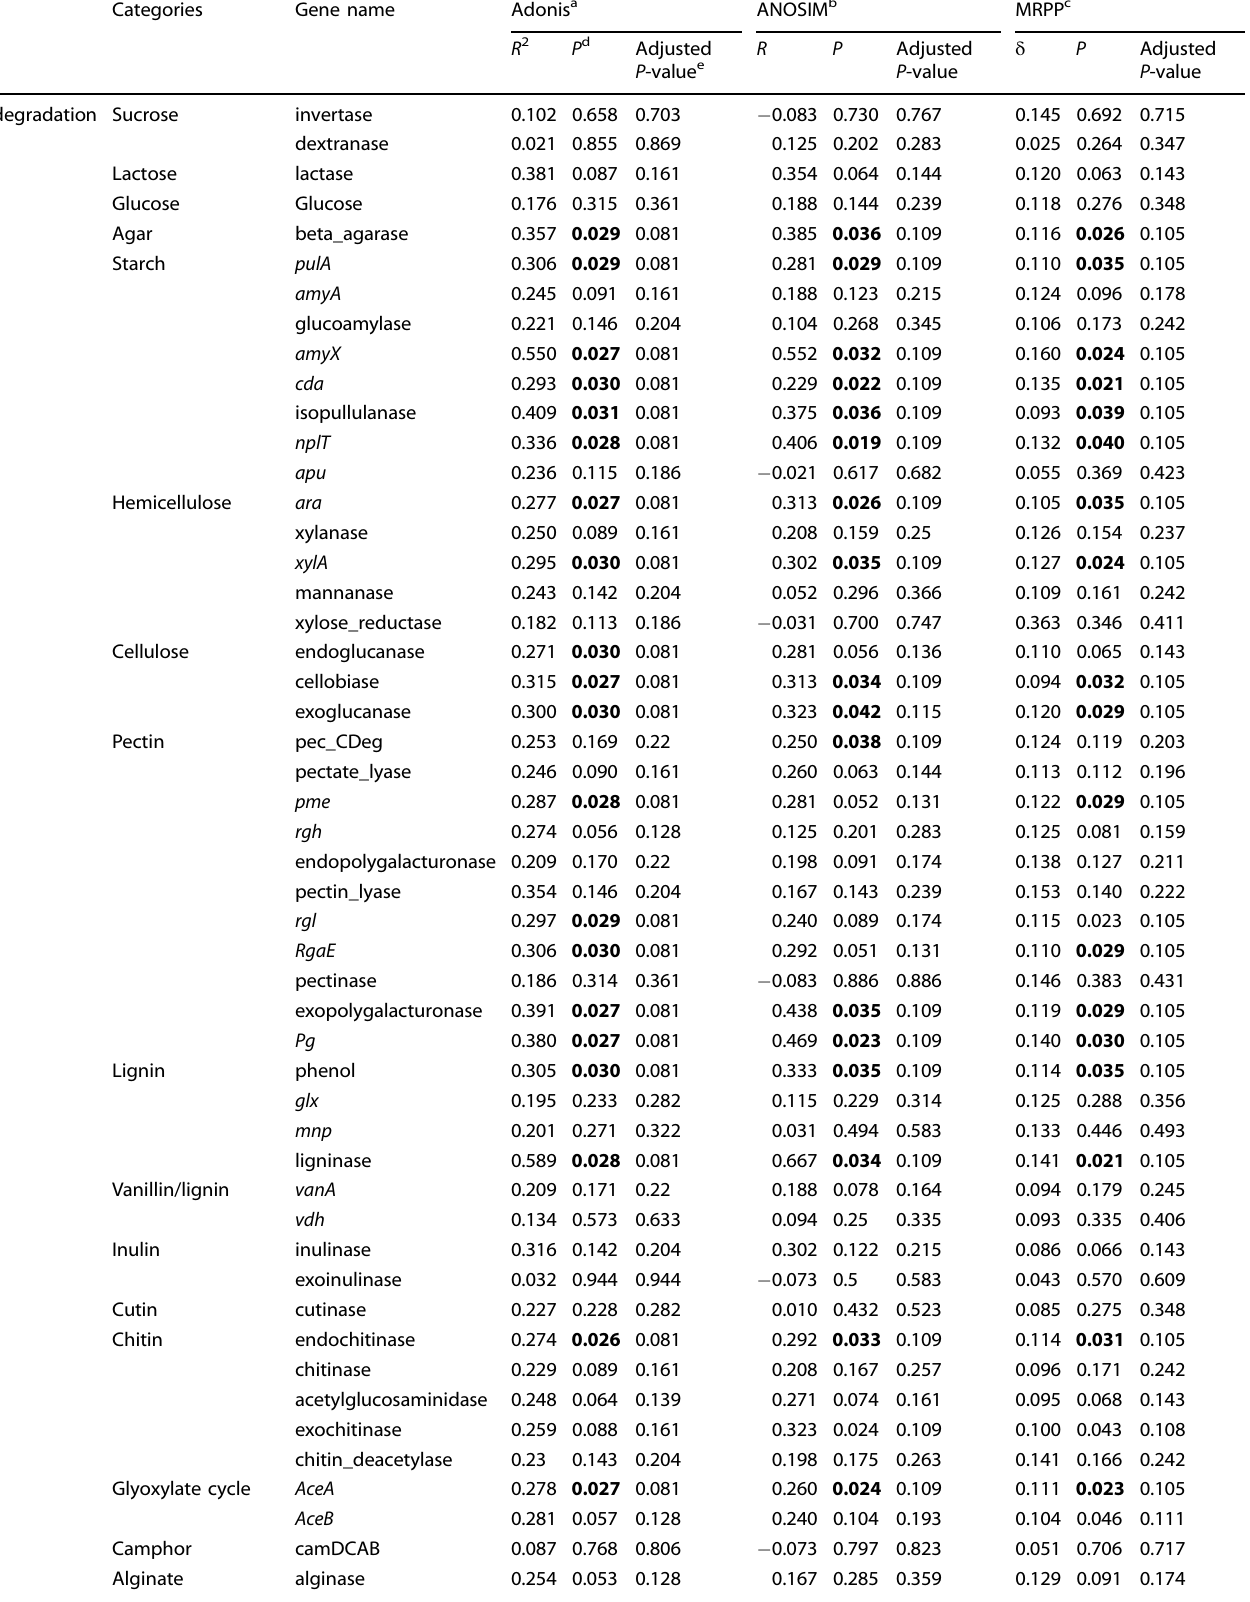
Table 2. Signi fi cance tests of the warming effects on the C degradation and N cycling gene compositions with three nonparametric statistical analyses ( n =